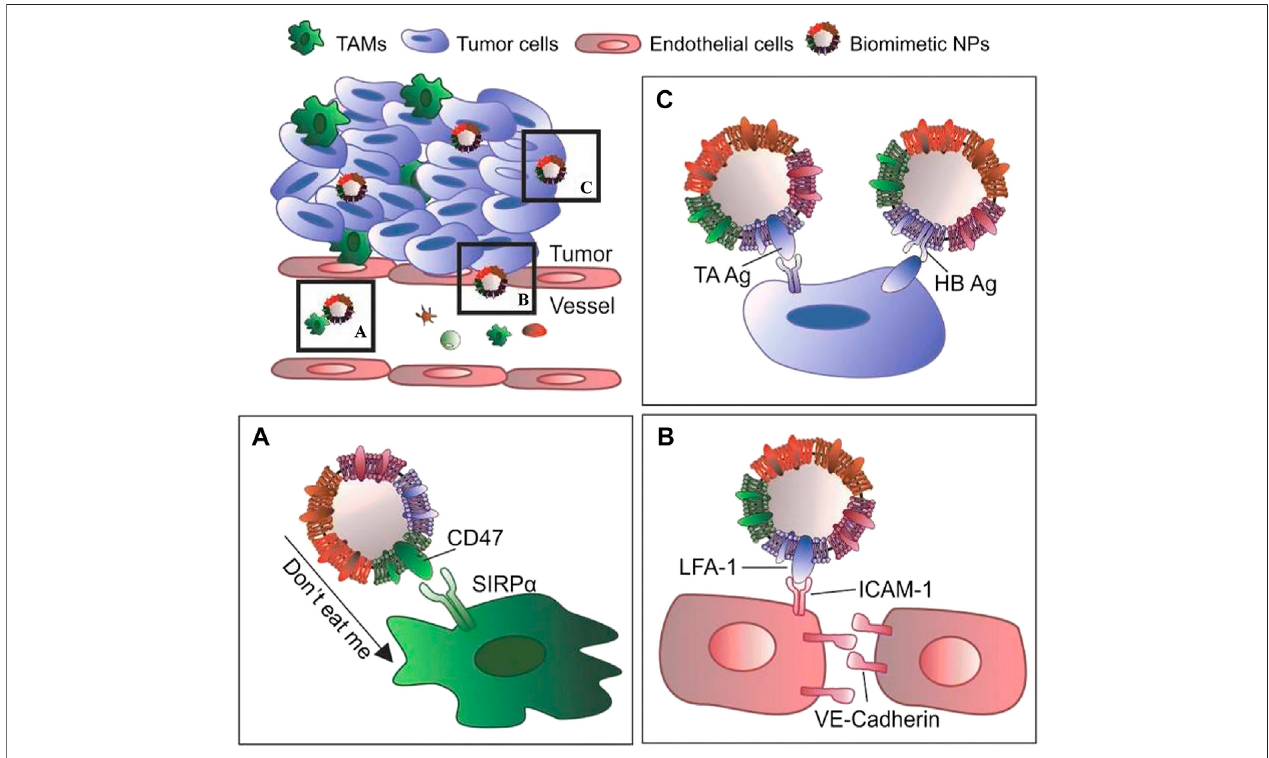
FIGURE1| Themainfunctionsoftheoutercellmembraneinclude: (A) protectingdrug-carryingNPsfromthebody ’ simmune system; (B) speci fi cbindingwiththe target cell receptor to achieve of activation or inhibition; (C) speci fi cally target tissues and lesion sites to improve ef fi ciency of drug delivery system (Reproduced from Pasto et al.,